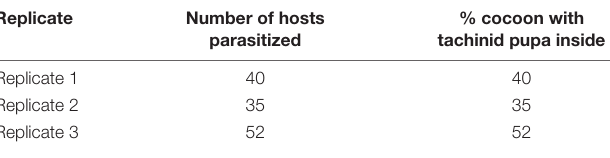
TABLE 3 | Number of silkworm cocoon with E. japonica pupa inside.